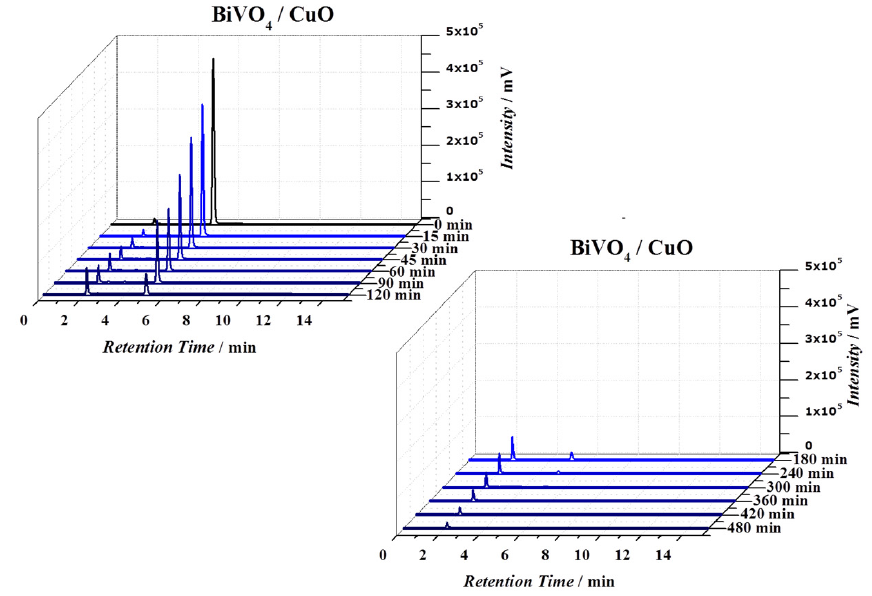
Figure 4. Chromatograms obtained by HPLC of samples collected during the 4-nitrophenol degradation experiments at different interval times.